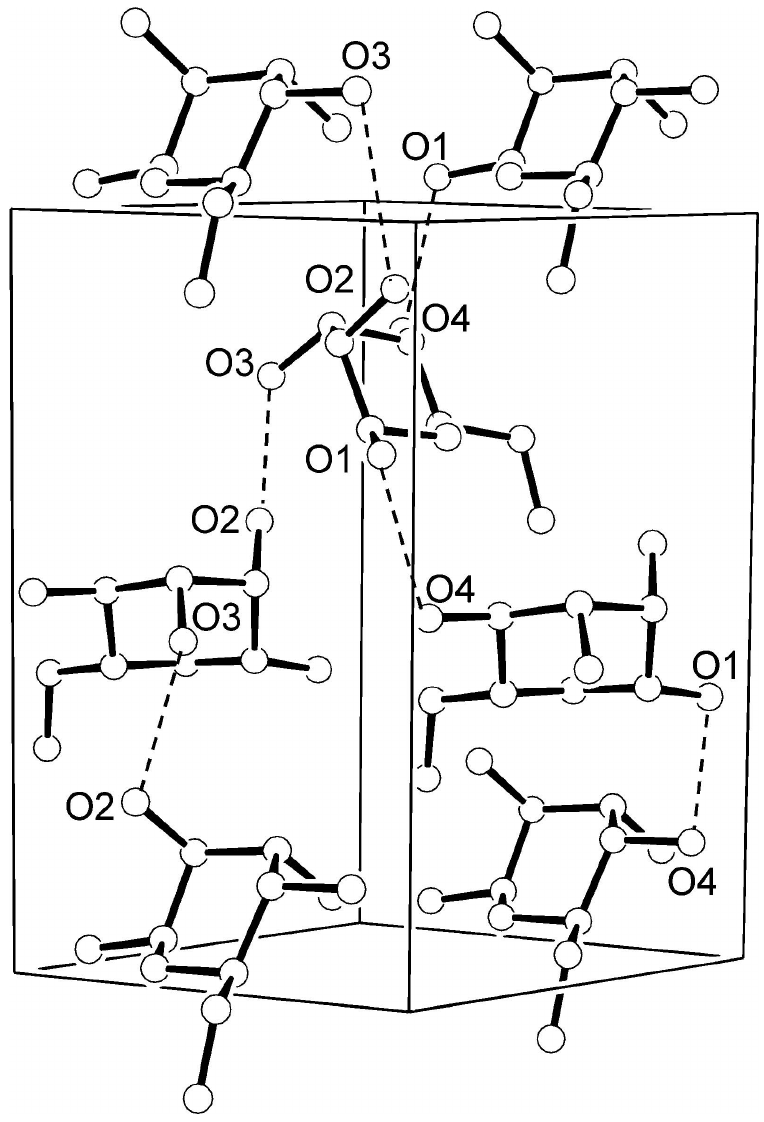
Crystal packing of β -D-altrose, with two helices along the z axis shown as dashed lines. (2R,3S,4R,5R,6R)-6-(hydroxymethyl)oxane-2,3,4,5-tetrol Crystal